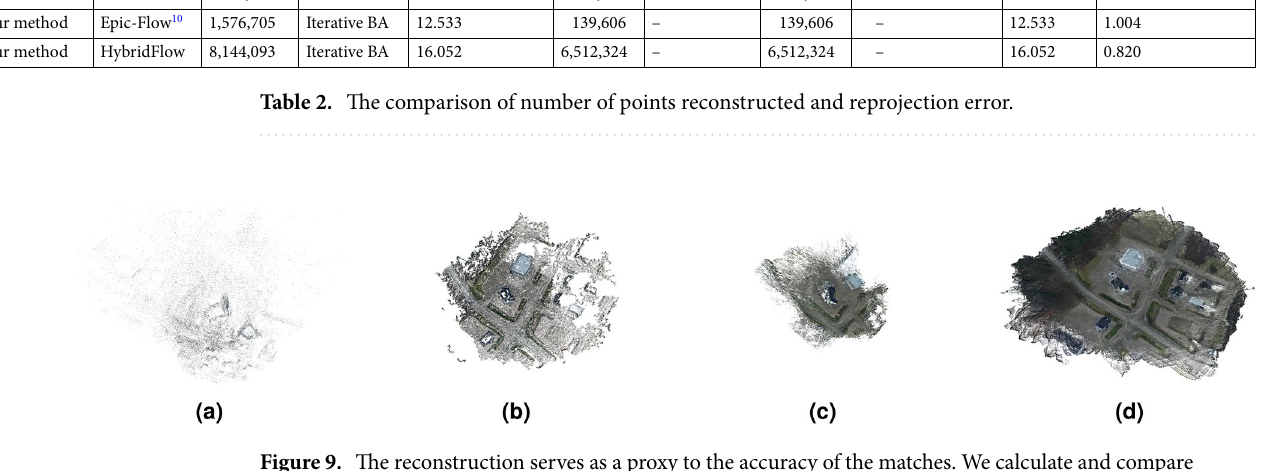
Figure 9. The reconstruction serves as a proxy to the accuracy of the matches. We calculate and compare reprojection errors for the techniques shown in Table 2. ( a ) Shows COLMAP’s sparse (SfM) reconstruction, ( b ) shows COLMAP’s dense (MVS) reconstruction 40 , ( c ) shows our single step reconstruction using dense matches from Epicflow 10 , and ( d ) shows our single step reconstruction with Hybridflow. HybridFlow produces 60 × more matches than COLMAP and 47 × more matches than EpicFlow. The reprojection error is comparable with COLMAP (for 60 × more points) while the runtime is less than